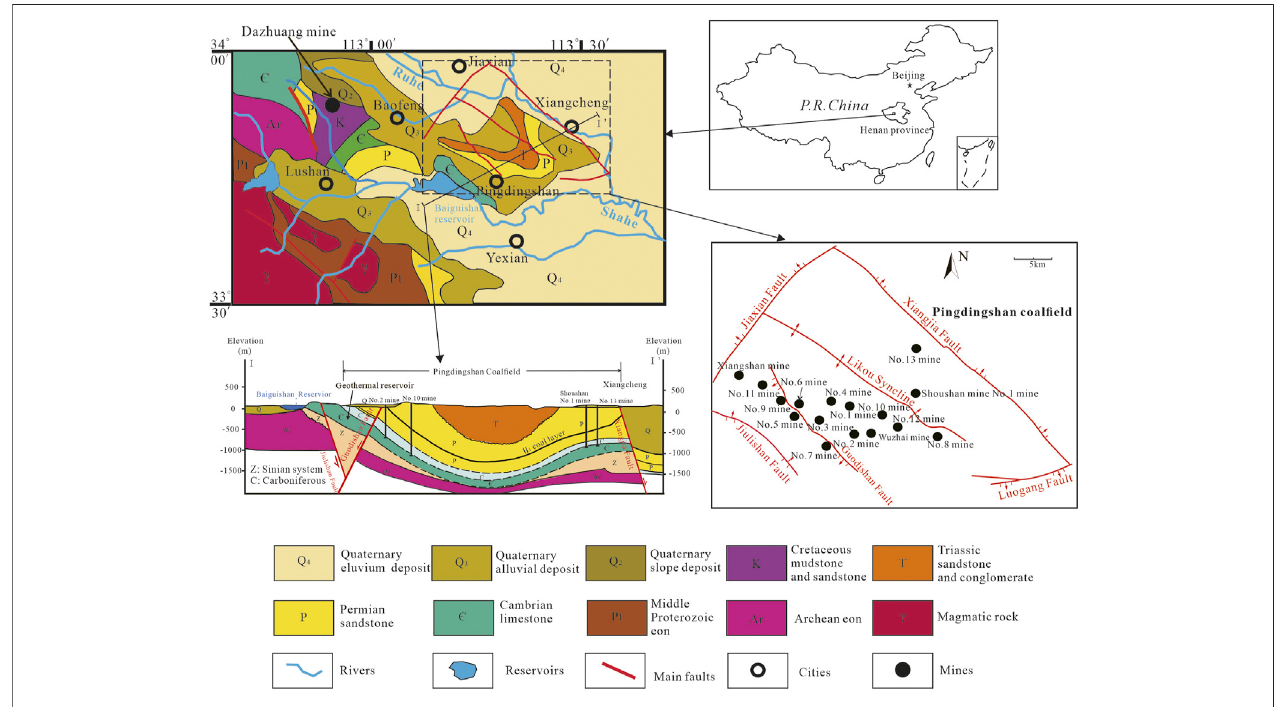
FIGURE 1 | Geological setting and mine positions in the Pingdingshan coal fi eld.